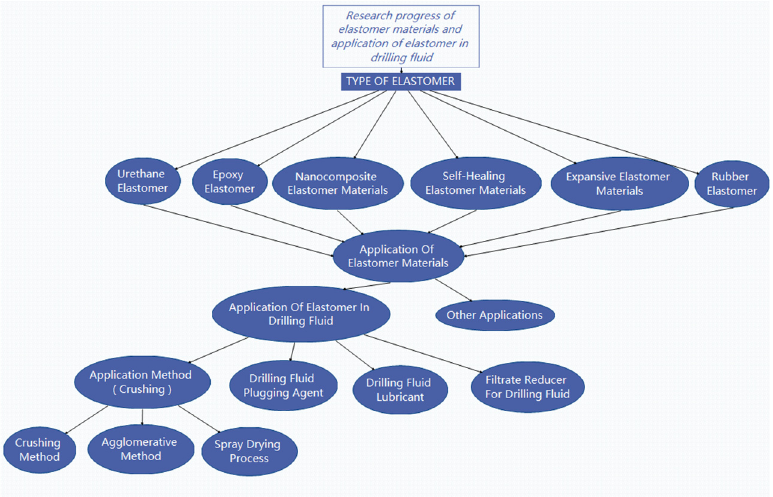
Figure 1. The research progress of elastomer materials and their applications in drilling